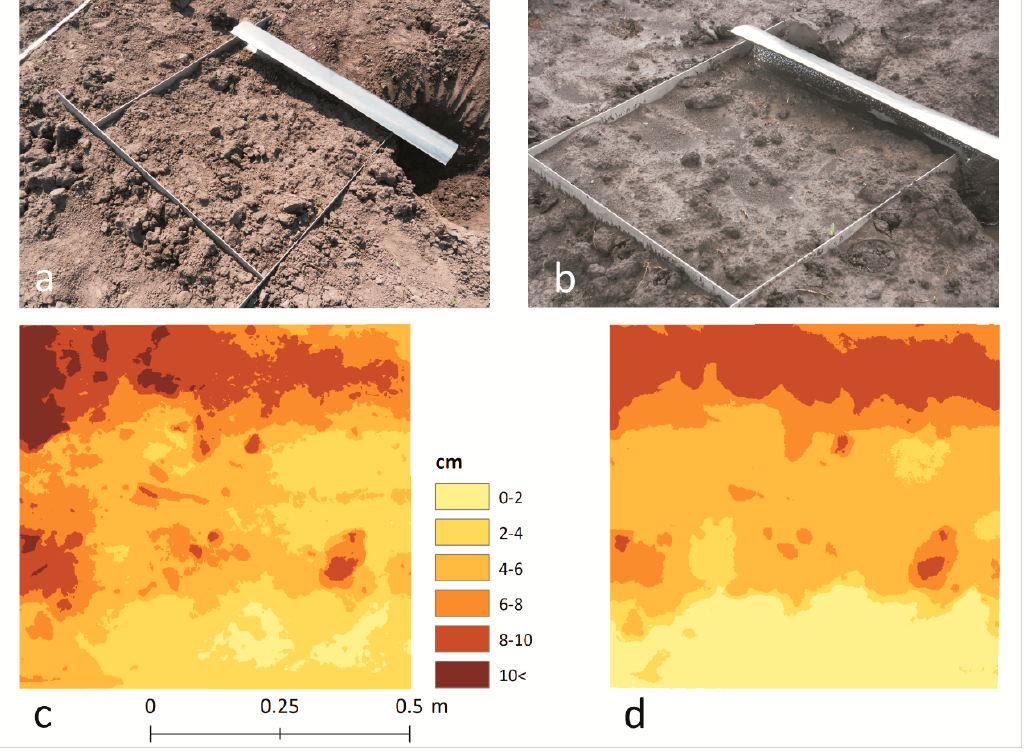
Figure 4. Surfaces of the Phaeozem soil under seedbed conditions before ( a ) and after ( b ) precipitation, and the built elevation models ( c , d ). The models were rotated clockwise by approximately